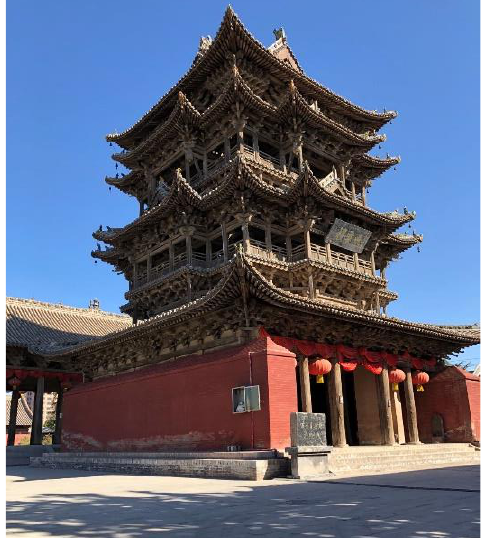
Figure 4. The Feiyun Pavilion.